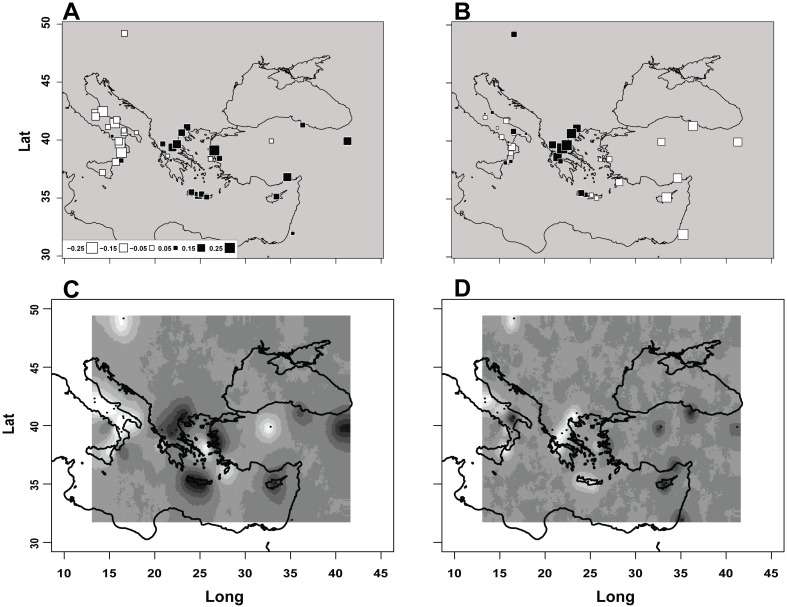
Maps of: A) scores for the 41 locations in sPC1 obtained on the full dataset with adegenet; B) scores in sPC2 obtained as in A; C) posterior assignment probabilities of the 41 locations to either of two clusters obtained on the reduced dataset derived from sPC1 with Geneland; D) posterior assignment probabilities of the 41 locations to either of two clusters obtained on the reduced dataset derived from sPC2 with Geneland.In A and B white and black squares represent negative and positive scores, respectively, with square size proportional to the absolute value (inset in panel A). In each of panels C and D shades of grey indicate probabilities of assignment to one of two mutually exclusive clusters from 0 (dark grey) to 1 (white). Color versions of panels C and D are reported in S7 Fig.